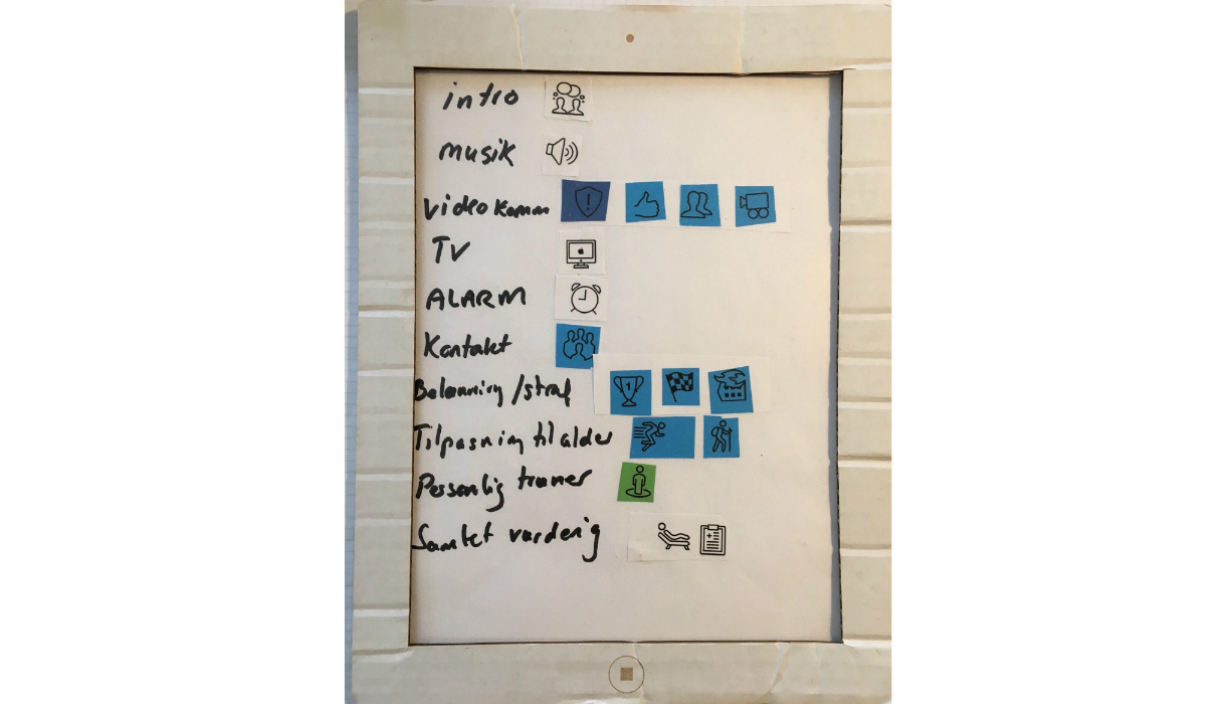
Figure 2. Suggestions for features in the app. The features are: introduction, music, camera, TV, alarm, award, age, personal trainer, and overall assessment.